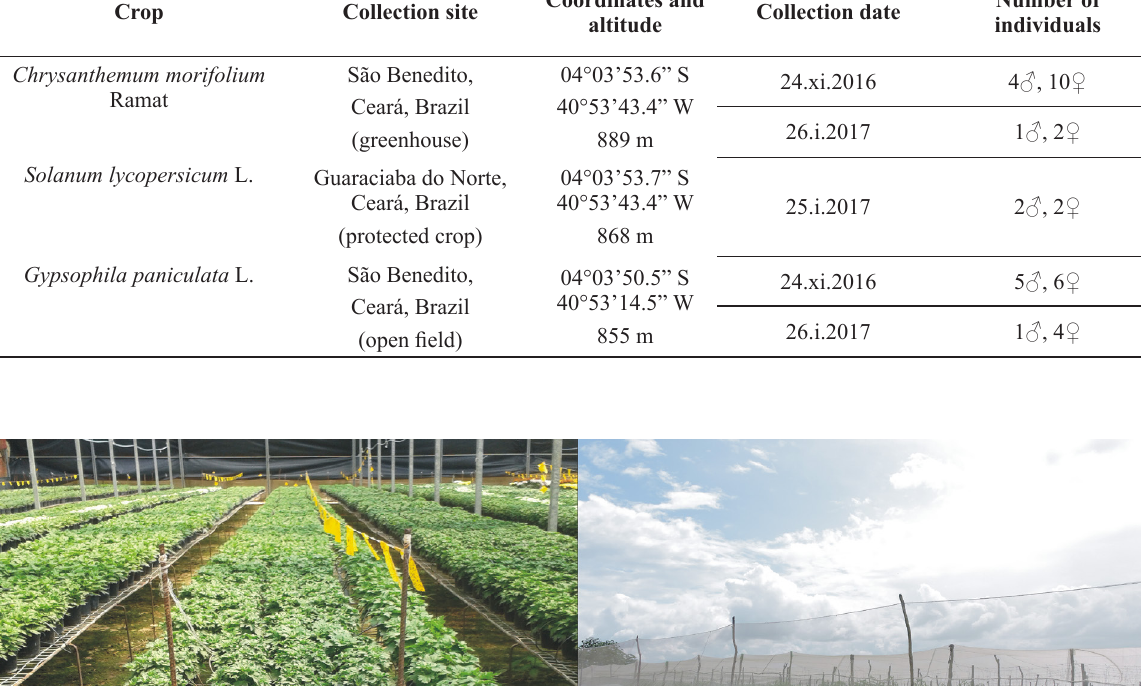
Summary of specimens of Coenosia attenuata Stein (Diptera, Muscidae) captured in entomological nets placed in greenhouses, protected crop and in an open field site in Northeastern Brazil by Sousa and Braga. Collection site